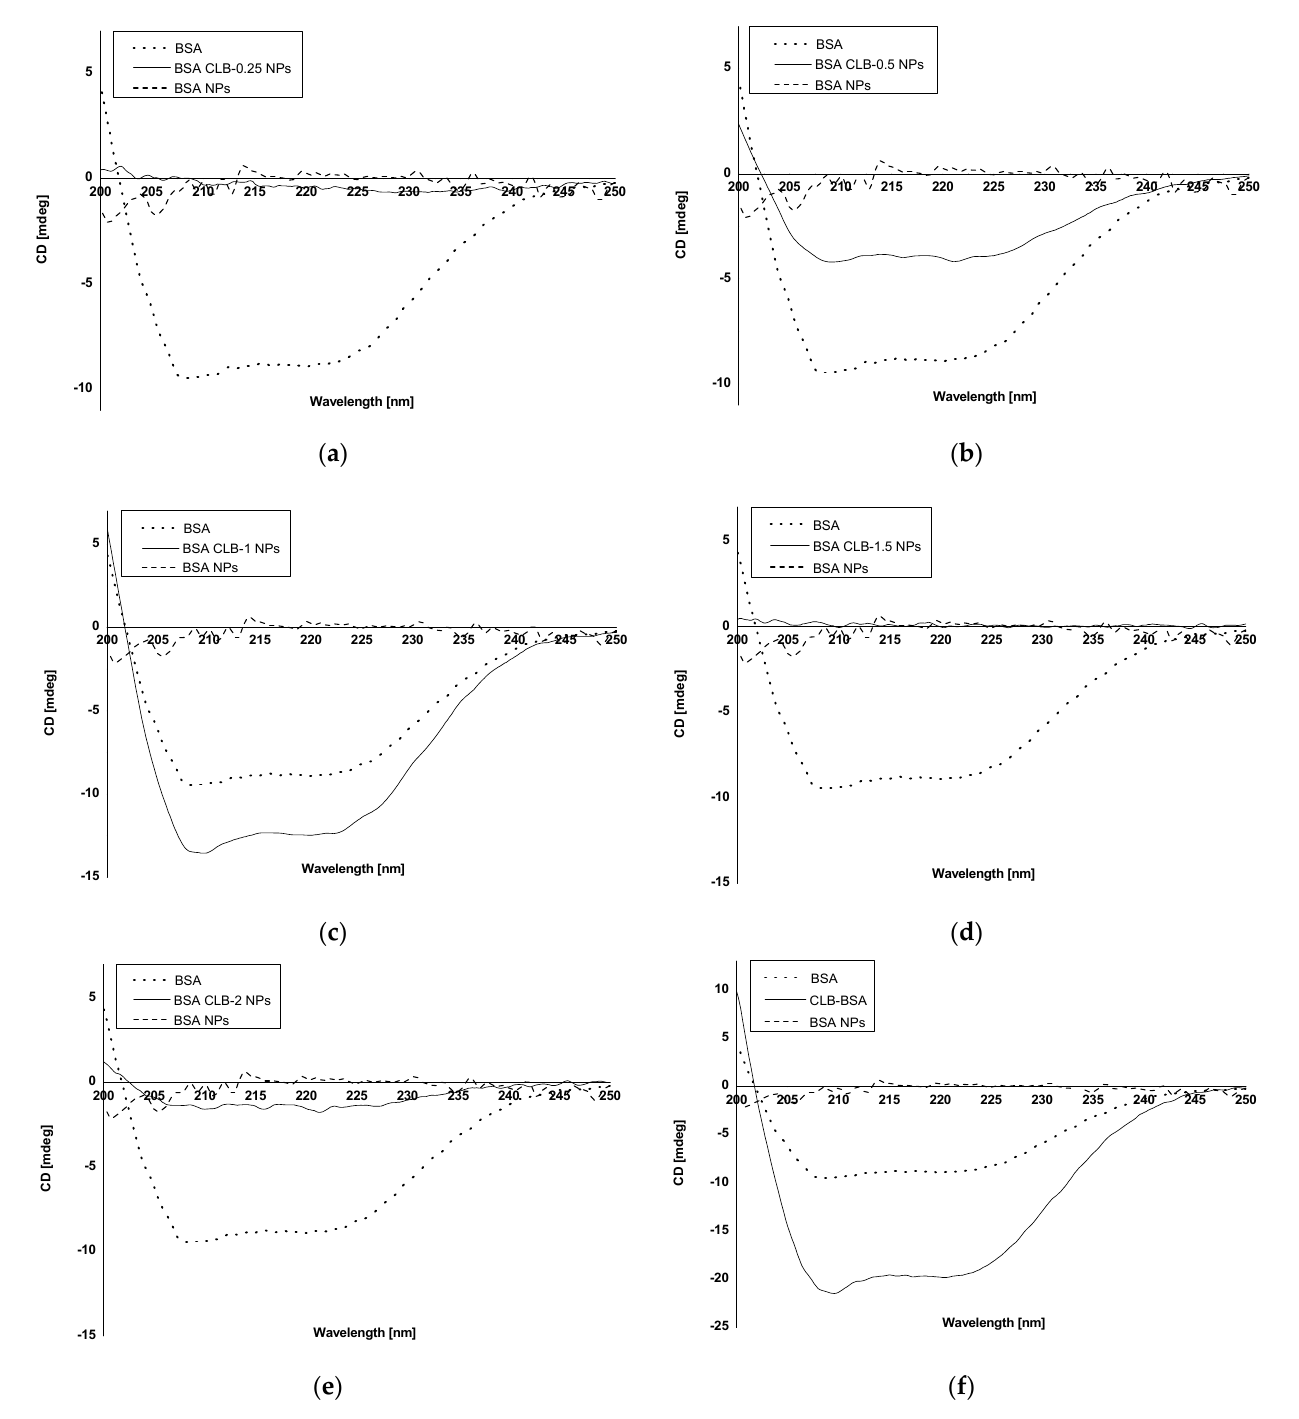
Figure 3. CD spectra: ( a ) native BSA, BSA CLB-0.25 NPs and BSA NPs; ( b ) native BSA, BSA CLB- 0.5 NPs and BSA NPs; ( c ) native BSA, BSA CLB-1 NPs and BSA NPs; ( d ) native BSA, BSA CLB-1.5 NPs and BSA NPs; ( e ) native BSA, BSA CLB-2 NPs and BSA NPs; ( f ) native BSA, CLB–BSA complex and BSA